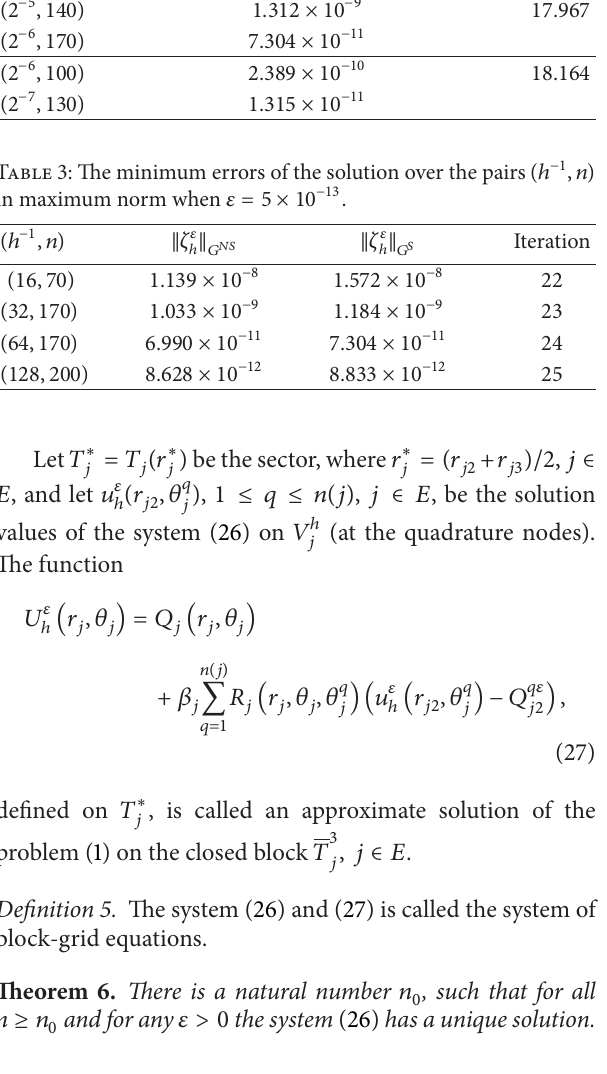
‖ R 󰜚 ℎ 𝐺 𝑆 𝐺 𝑆 1.294 × 10 −9 16.789 7.708 × 10 −11 1.312 × 10 −9 17.967 7.304 × 10 −11 2.389 × 10 −10 18.164